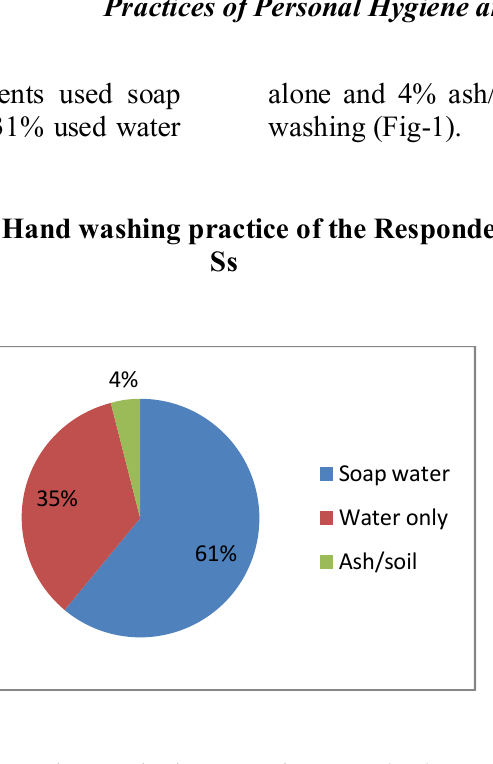
Table 2. Knowledge of sanitation and personal hygiene among community people